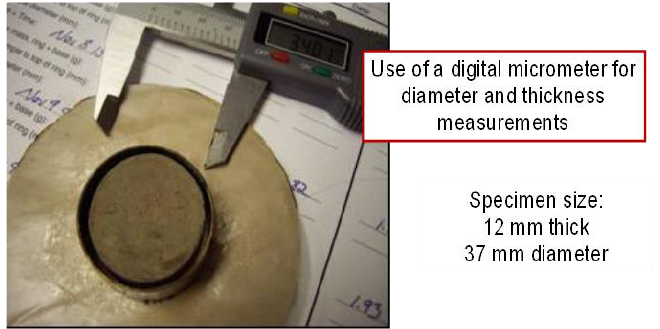
Figure 5. Use of a micrometer to measure the volume at various degrees of drying.